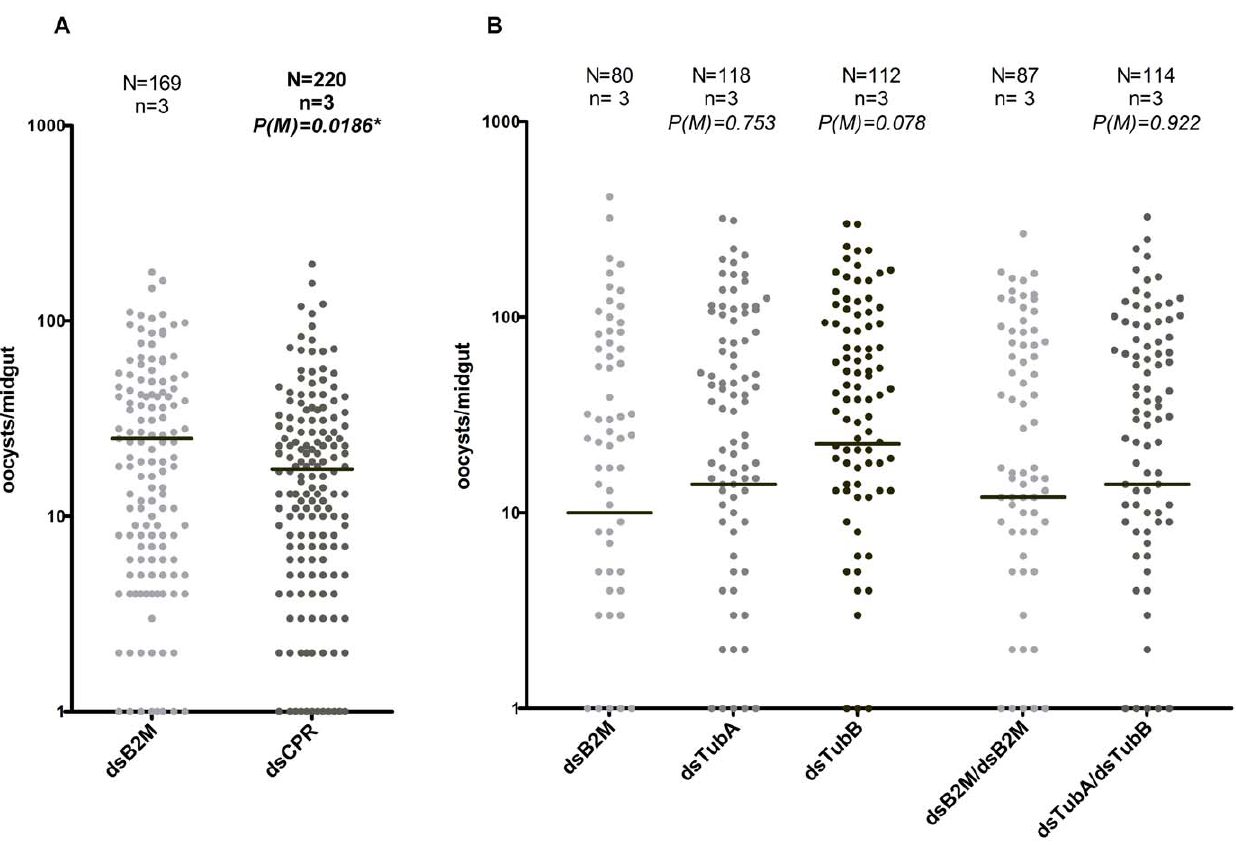
Figure 1. Effect of silencing CPR (A), tubA , tubB , or co-silencing tubA and tubB (B) on P.berghei infection at 8 days after an infected blood meal. The dots represent the number of parasites present on individual midguts, and the median number of oocysts is indicated by the horizontal line, where N is the total number of mosquitoes analyzed and n is the number of independent experiments. Oocysts distributions are compared using Mann-Whitney (M) test. * indicates significant differences ( p , 0.05).